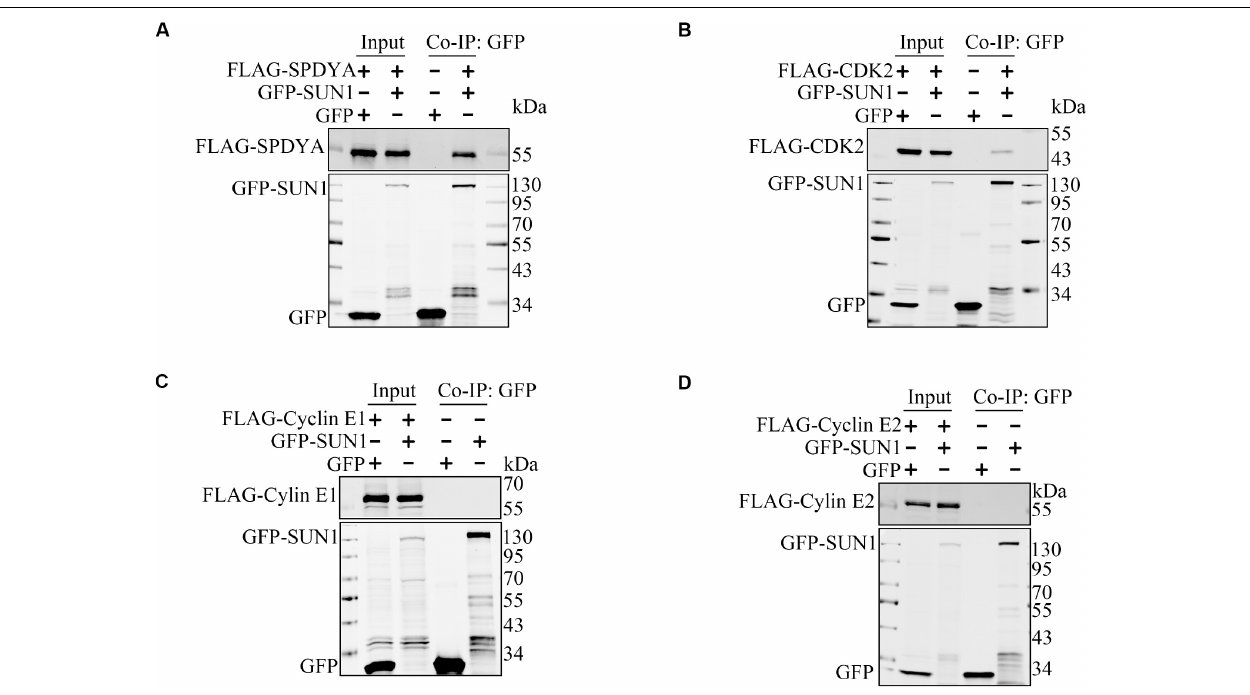
FIGURE 3 | SUN1 interacts with SPDYA. The expression plasmids were transfected into HEK293T cells, and immunoprecipitation was performed to analyze the interaction of SUN1 with SPDYA (A) , CDK2 (B) , Cyclin E1 (C) , and Cyclin E2 (D) .